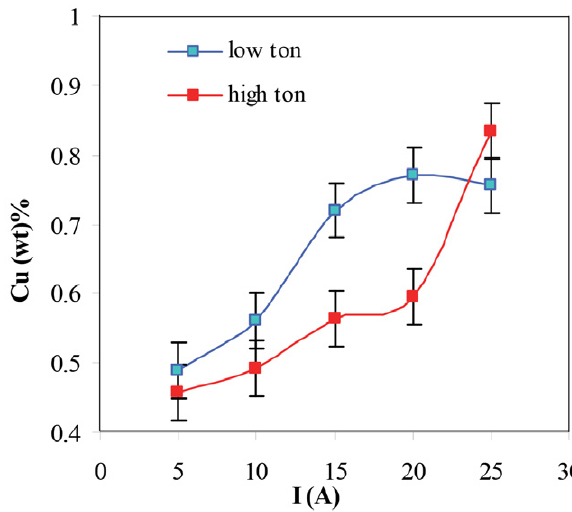
Figure 6. Diagram of diffused copper wt. % vs. discharge current at high and low t on .